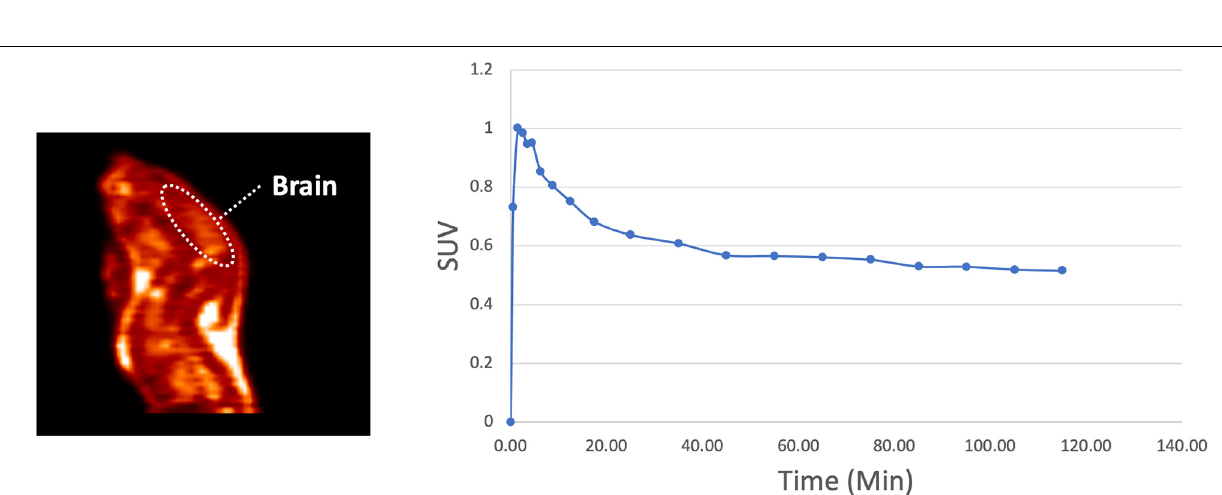
FIGURE 3 | Autoradiography correlates with immunohistochemistry for individual data points (A) and average B max (fmol/ µ g) values (B) .